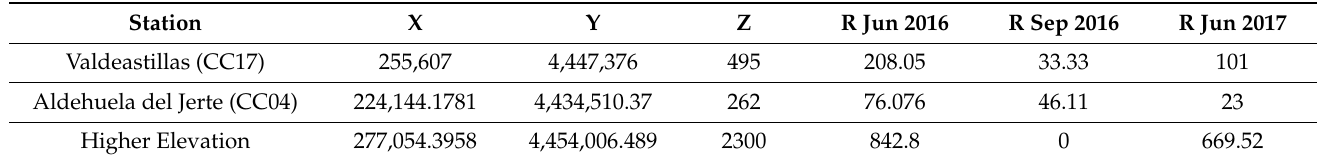
Table 2. Location of weather stations and data of the R factor (Information elaborated using that obtained from the AEMET (Agencia Estatal de Meteorolog í a). Station X Y Valdeastillas